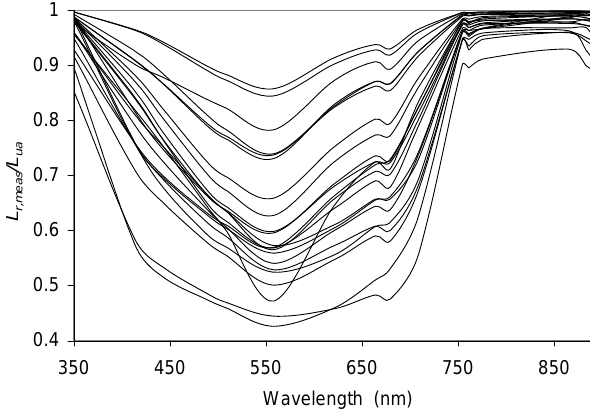
Figure 1. Spectral distribution of the measured radiance reflectance R r,meas .